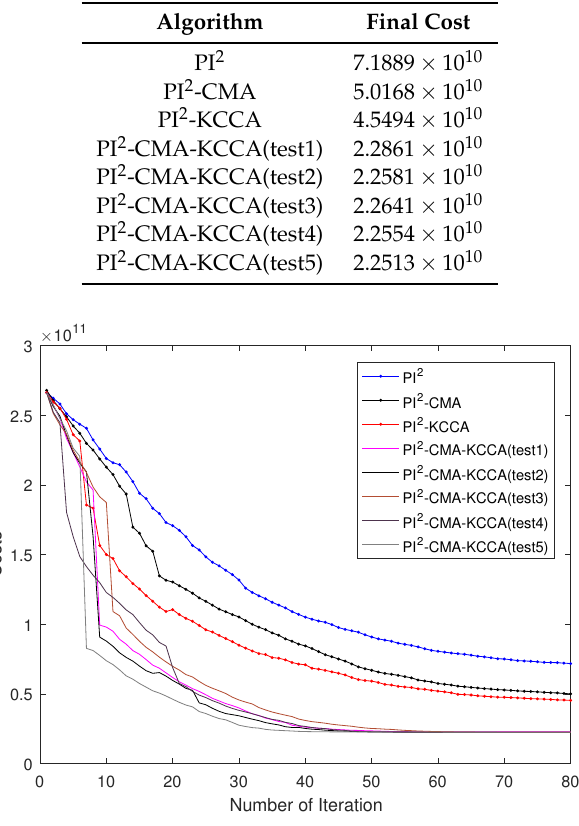
Figure 6. Cost of one via-point task.